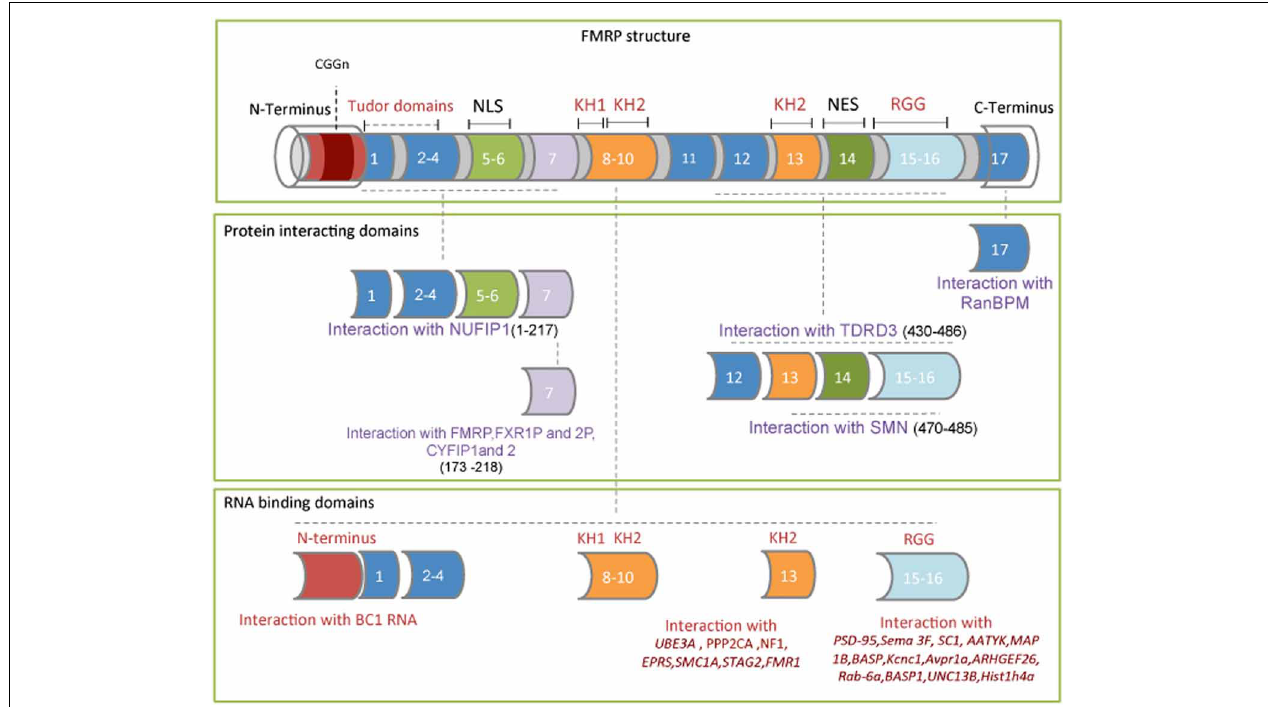
FIGURE 1 | FMRP exon structure comprising its functional domains. Upper frame: The red box at the N-terminus of exon 1 indicates the location of the CGG triplet repeat within the 5 (cid:2) UTR of the mRNA. The four RNA binding domains are: the N-terminus, the two K homology domains (KH1 and KH2) and the RGG box. Middle frame: FMRP domains interacting with